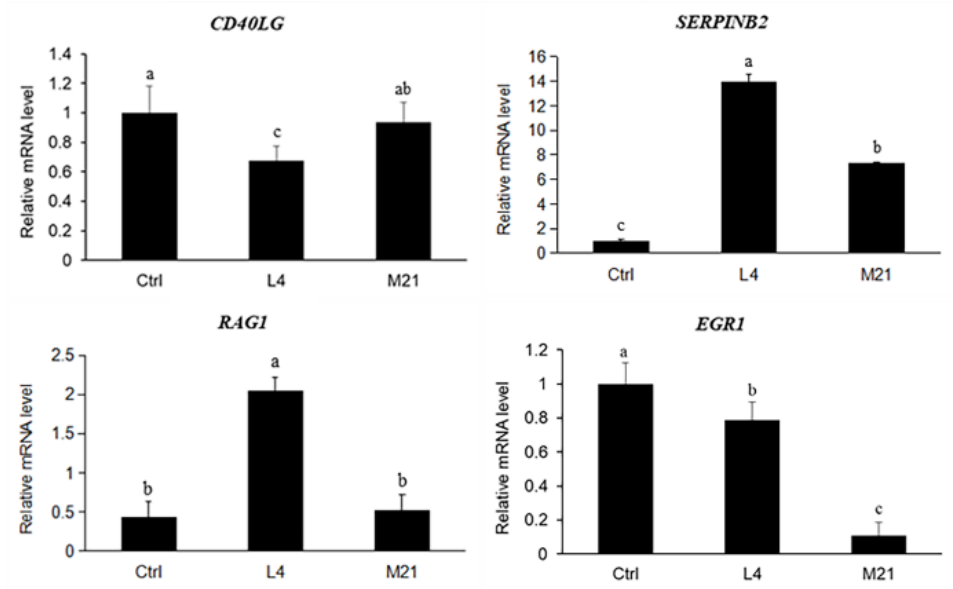
Figure 6. Quantitative real-time PCR results for the selected genes. Data are expressed as the mean ± SD from triplicate exposures. Different letters on the different bars indicate significant differences ( p <